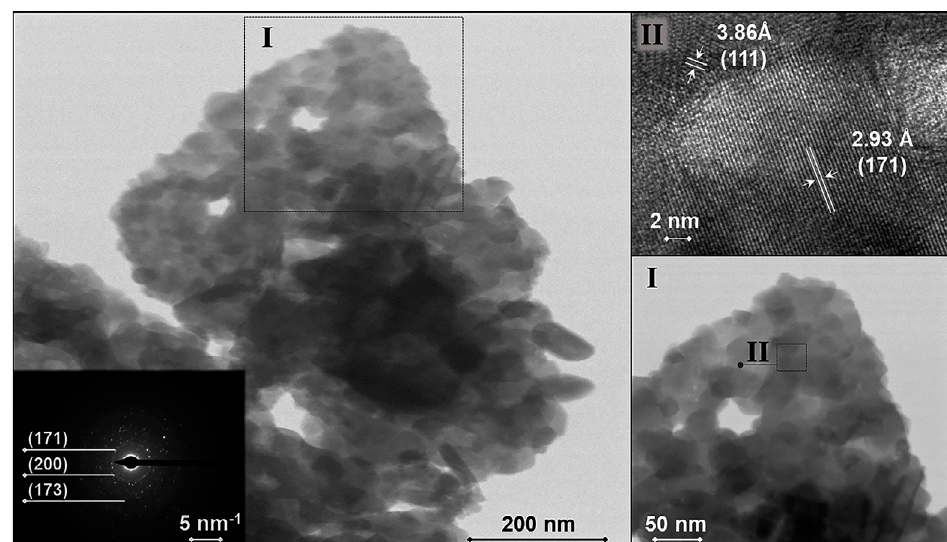
Figure 8. High Resolution Transmission Electrons Microscopy (HRTEM) and Electron Diffraction pattern for sample 600‒1